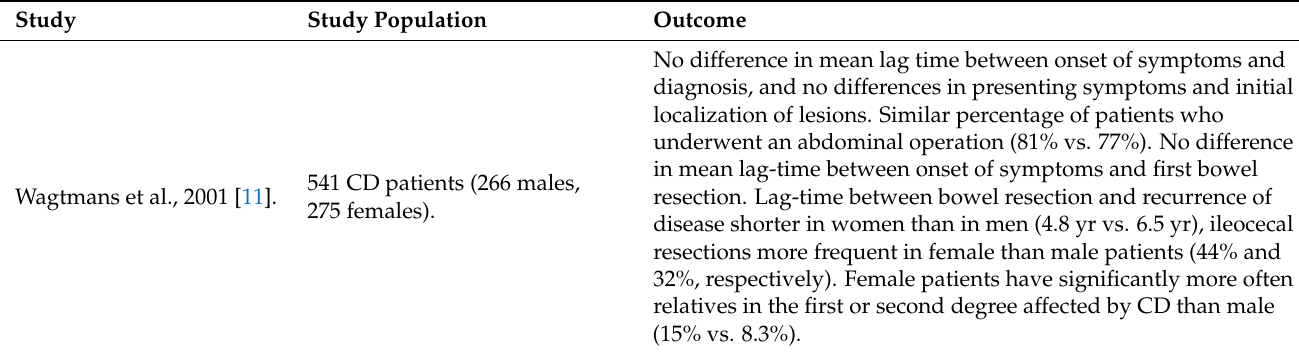
Table 2. IBD Clinical features and